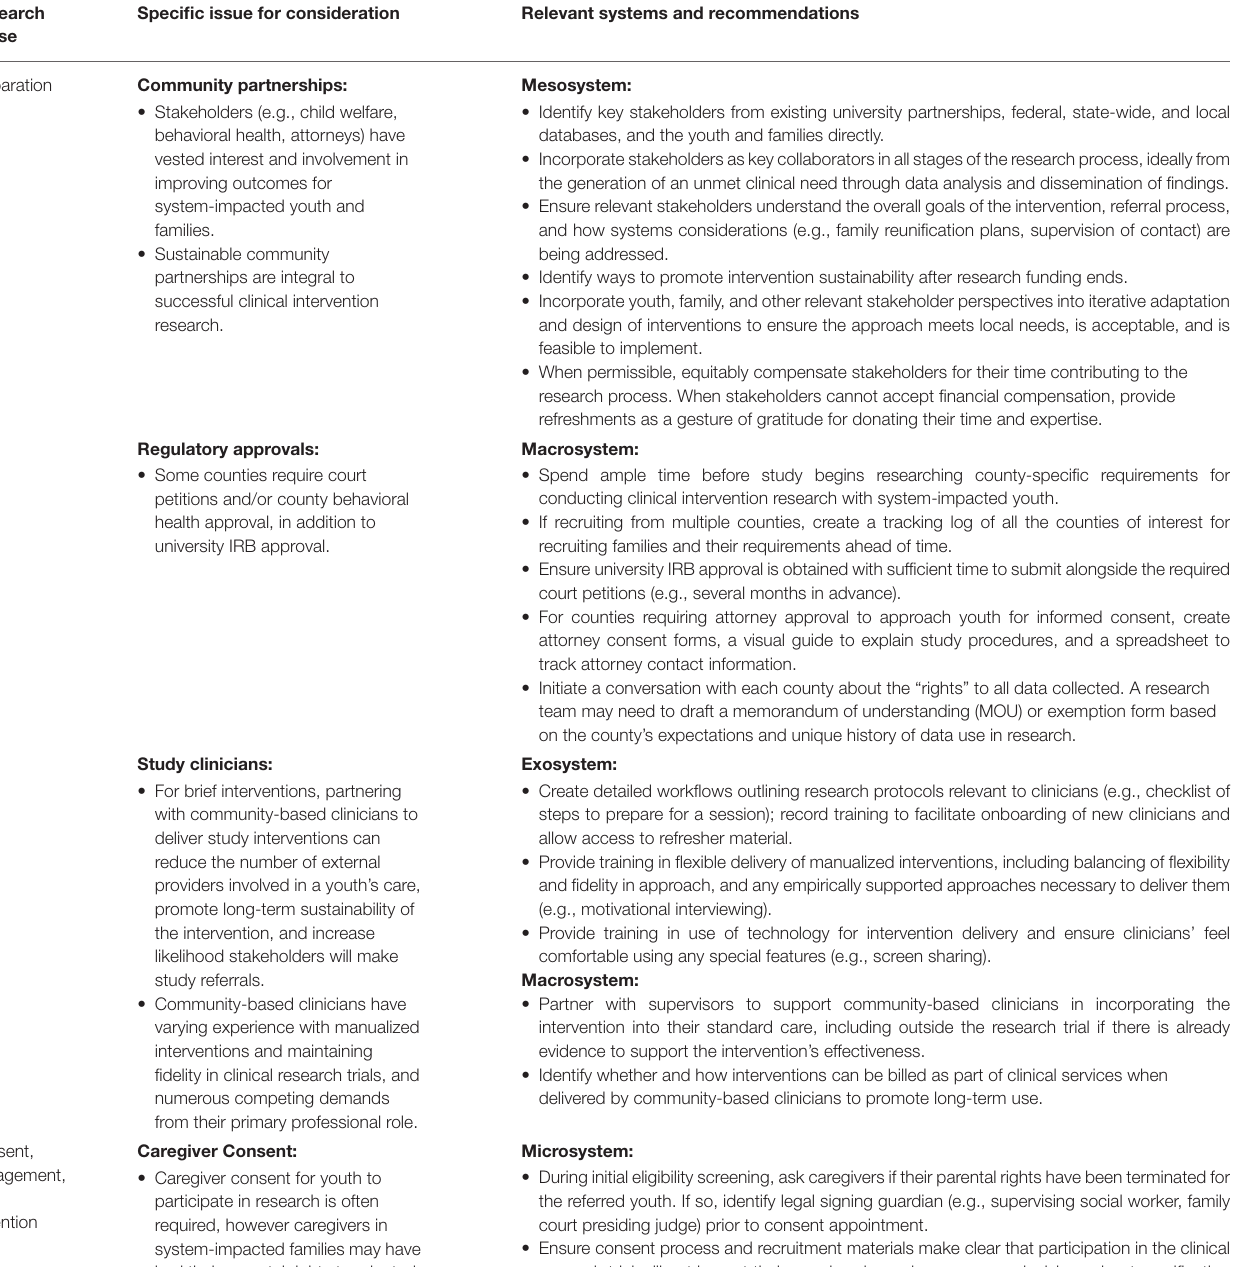
TABLE 1 | Select recommendations for conducting clinical research on family-based telehealth interventions with youth in foster care and their families. Research